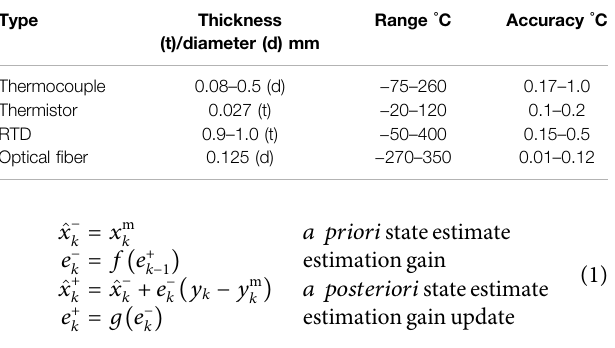
TABLE 4 | Comparison of hard